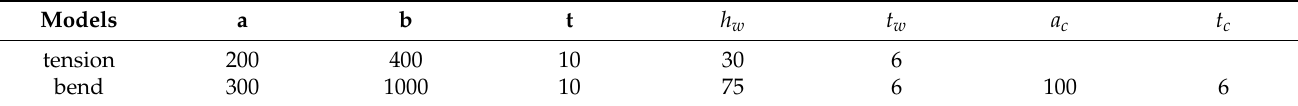
Table 4. Geometric dimensions of stiffened plates (unit: